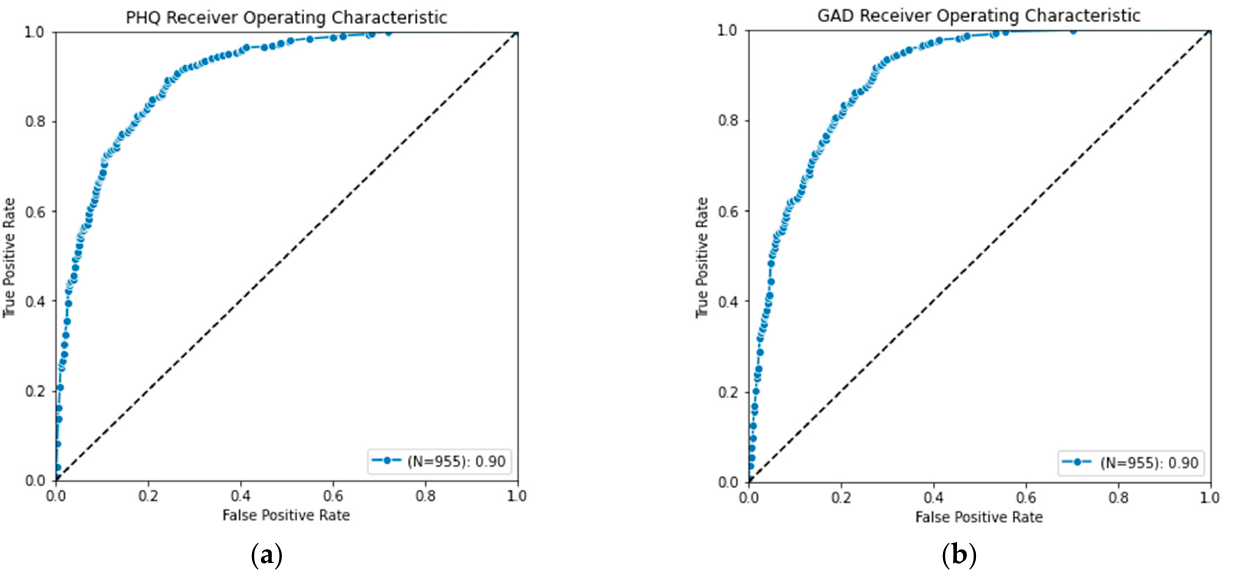
Figure 5. Receiver operating characteristics curve for ( a ) PHQ-V predictions and ( b ) GAD-V predictions.